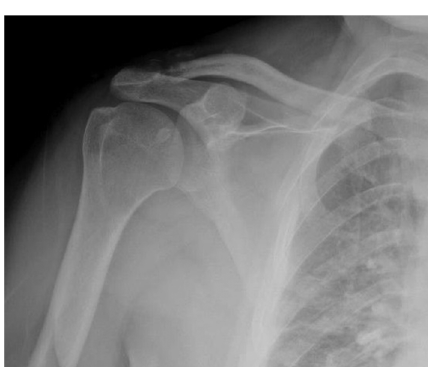
Figure 4. Final radiographs at 1 year showed good reduction of AC joint with minimal ossi fi cation, but no calci fi cation or bony bar imaging or joint space